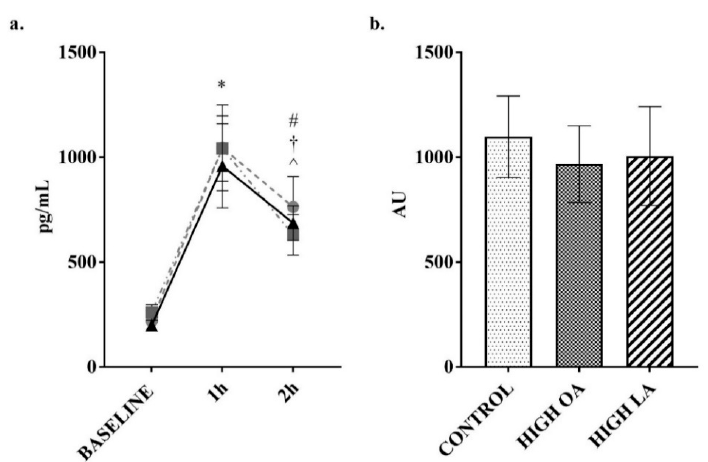
Figure 7. Change in glucose-dependent insulinotropic peptide (GIP) over 2 h postprandial period. ( a ) plotted values, = control meal, ■ = high-OA, ▲ = high-LA; ( b ) Net AUC from baseline. Measured in plasma using a multiplex immunoassay. All data displayed as mean ± SEM, all data points n = 8. * = significantly different to baseline for all test meals. # = significantly different ( p < 0.05) to baseline for control, † = signi fi cantly di ff erent ( p < 0.05) to baseline for high-LA test meal. ^ = significantly different ( p < 0.05) to 1 h for the high-OA test meal.